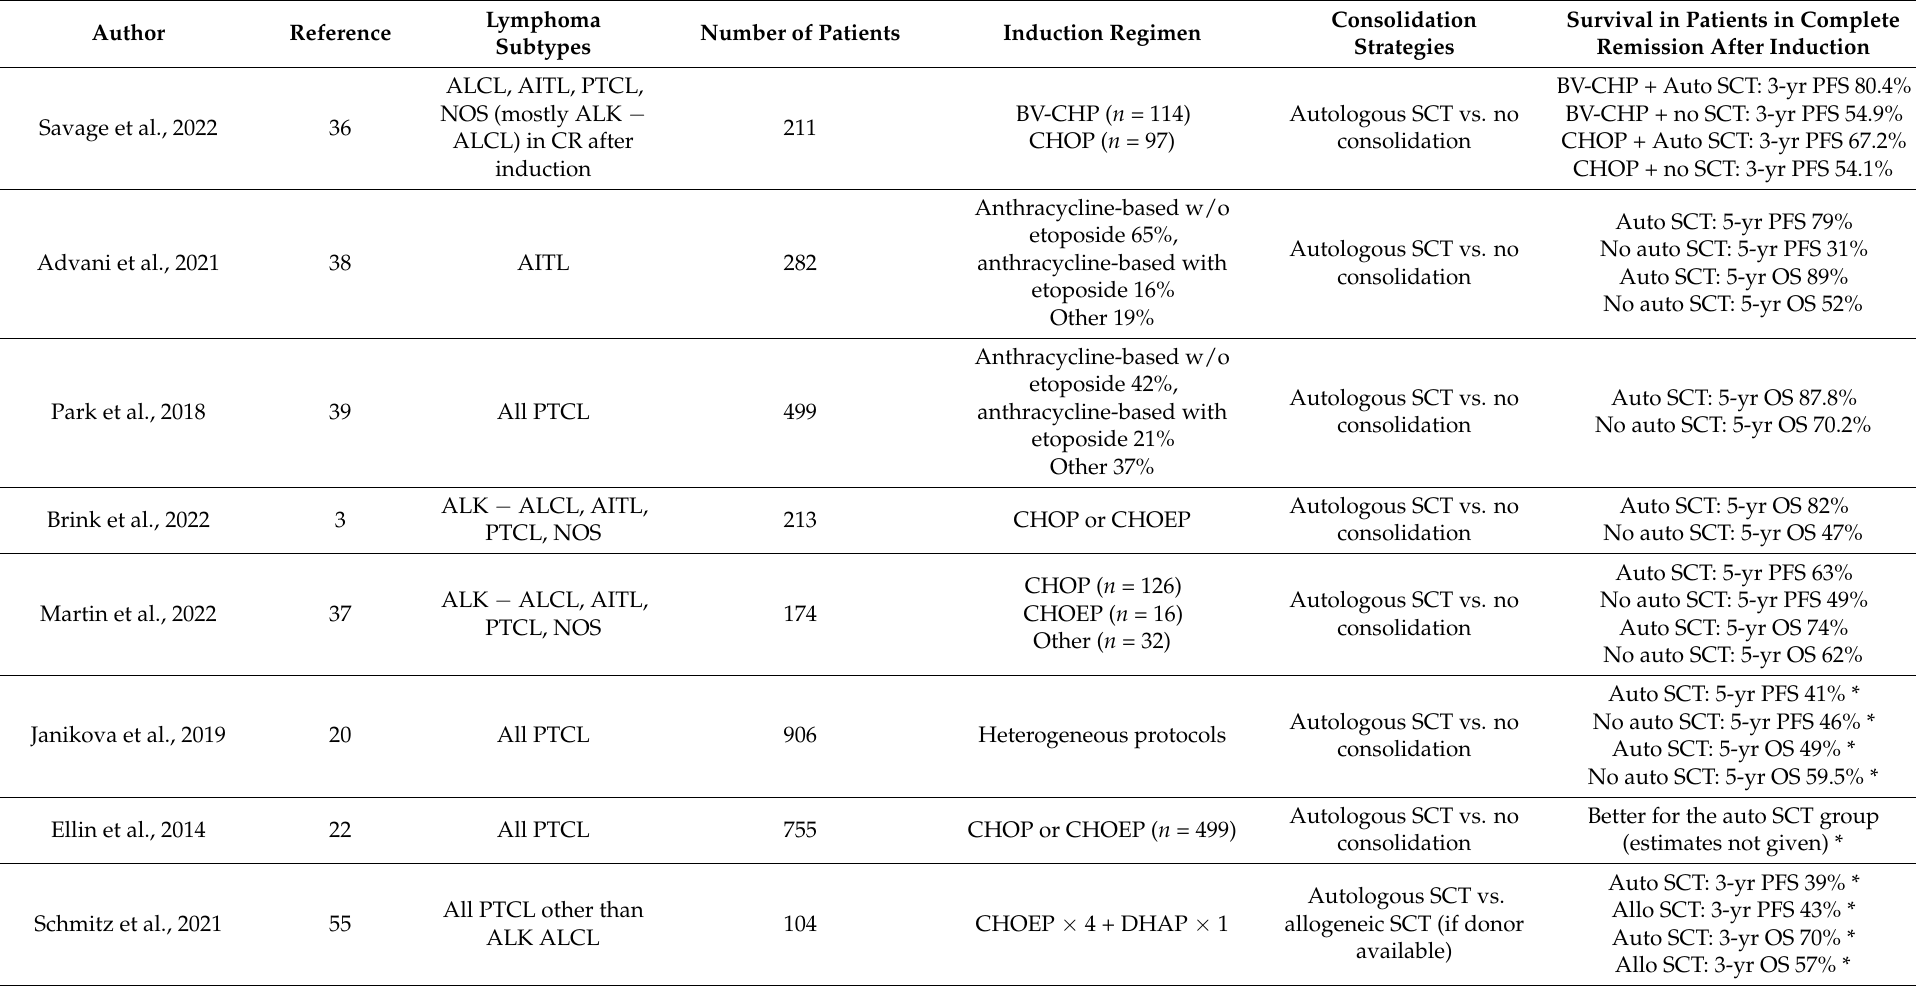
Table 1. Selected studies comparing consolidation with autologous stem cell transplantation with other strategies in peripheral T cell